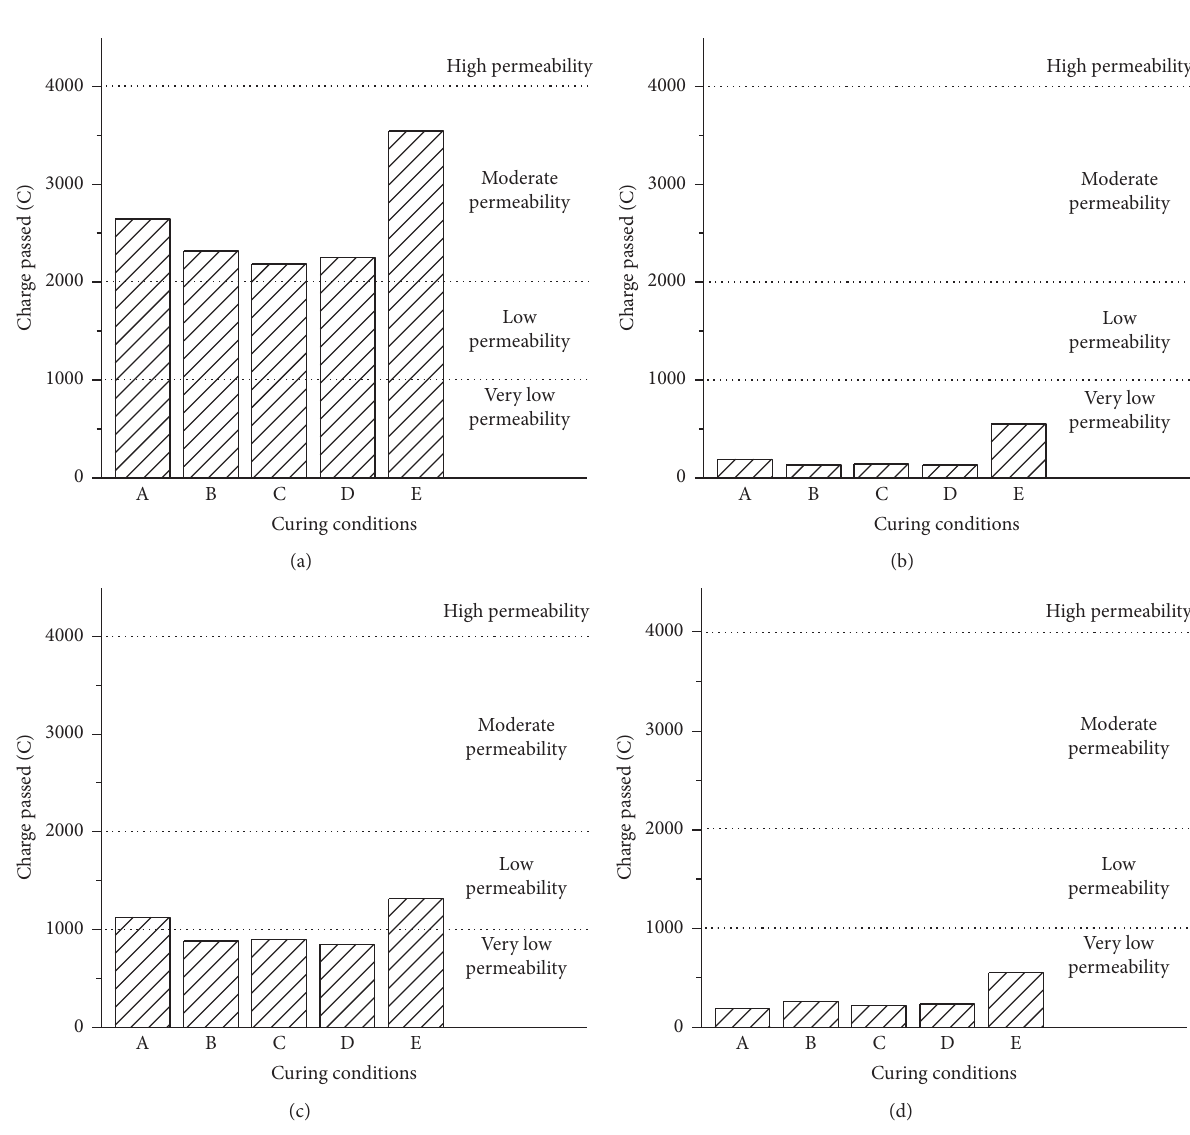
Figure 7: The chloride ion permeability of concrete at the age of 360 days. Samples: (a) plain cement, (b) 45% FA, (c) 45% GGBS, and (d) 12%